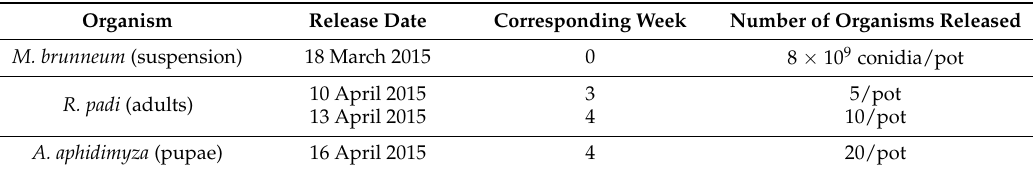
Table 1. The number and date of release of aphids and biological control agents over the course of the